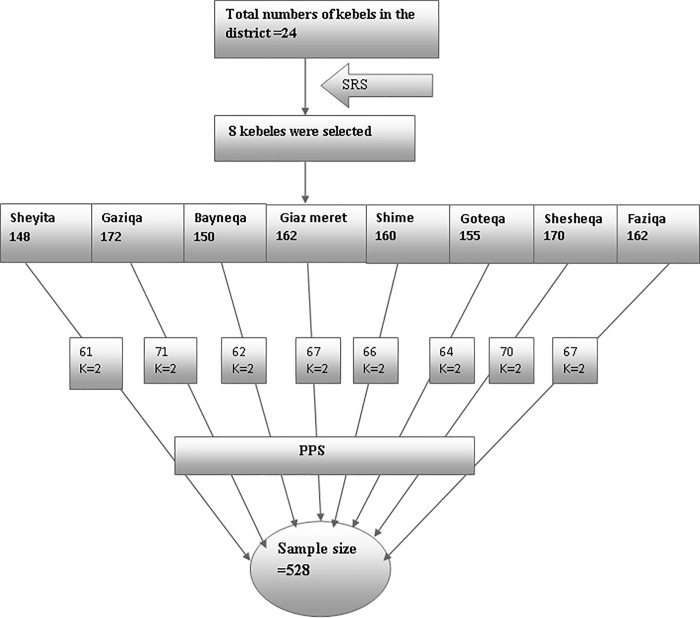
Sampling procedure of study participants in the CBHI piloted Sheko district, Southwest Ethiopia, 2018.SRS = simple random sampling; K = sampling interval; PPS = probability proportional to size.